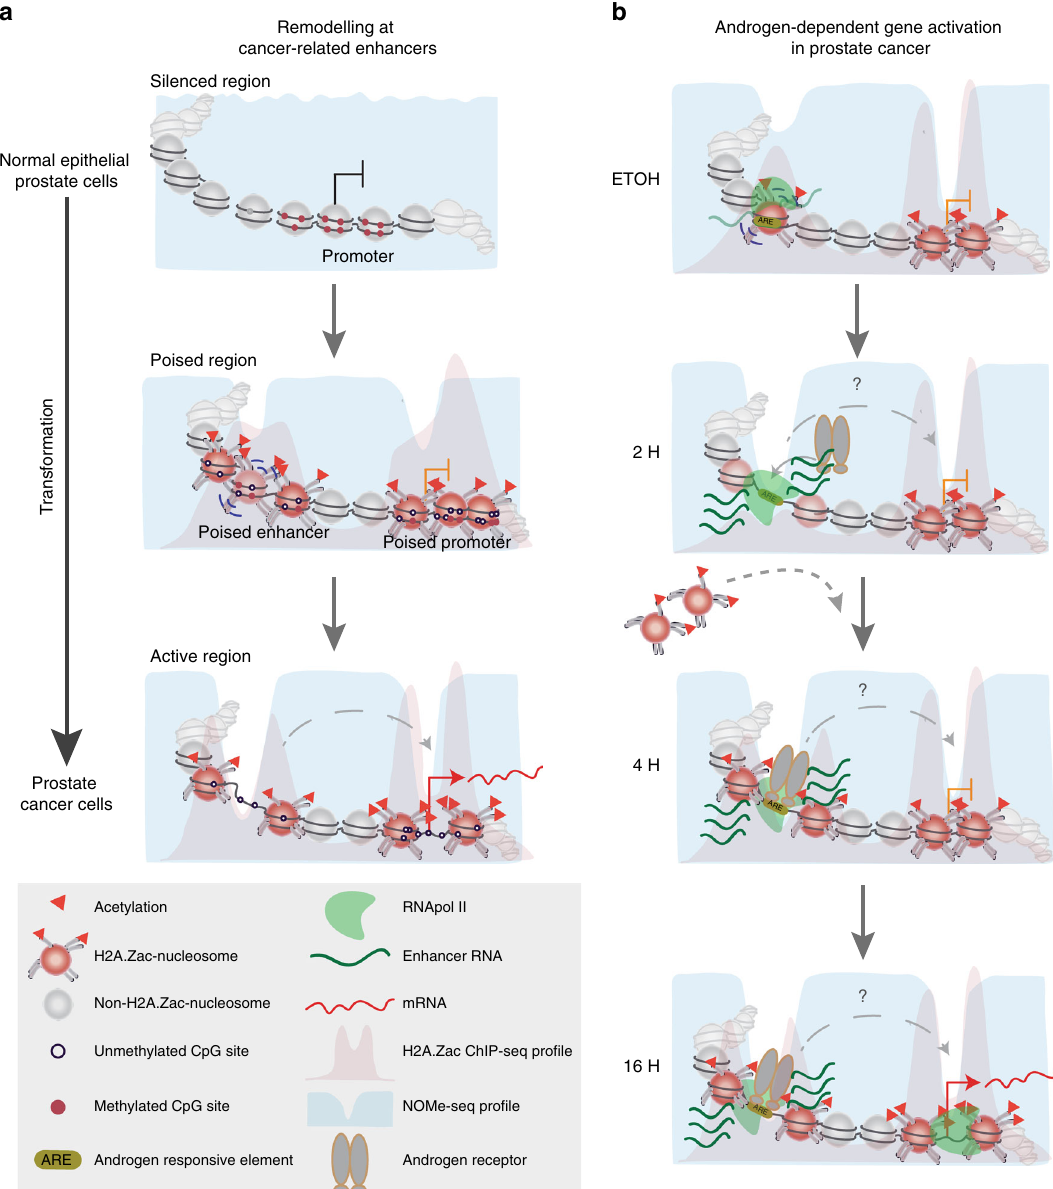
Fig. 9 Proposed model for H2A.Zac-enhancer regulation in cancer and androgen signaling. a Proposed model of regulation of cancer – activated genes. In a normal context, these genes are silenced and their promoters and enhancers do not have H2A.Zac-containing nucleosomes (Silenced region). During transformation, these genes gain poised epigenetic marks that include a gain of H2A.Zac, loss of DNA methylation and gain of chromatin accessibility at both promoters and enhancers (Poised region). In prostate cancer these genes become activated by an increase of H2A.Zac and a change in its localization from the TSS and +1, +2 nucleosome to fl ank the TSS at promoters. H2A.Zac is also increased at enhancers and it changes from occupying to fl ank NDRs. These changes are also associated with a decrease in DNA methylation. b Proposed model for H2A.Zac remodeling during androgen signaling. Androgen- sensitive genes remain in a poised state during androgen deprivation (EtOH). This state is characterized by the presence of H2A.Zac nucleosomes at 60% of all the AR enhancer sites and H2A.Zac presence at the nucleosomes fl anking the TSSs of all the androgen-sensitive genes. This subset of AR enhancer sites is also characterized by being more accessible. Upon AR activation through DHT treatment (2H, 4H, and 16H), H2A.Zac is removed/shifted to fl ank AR sites and allow AR binding. This is a very rapid process and occurs prior to gene activation and it is associated with a gain in chromatin accessibility at the AR enhancer sites. We also speculate that this remodeling facilitates the looping formation between gene promoters and AR-enhancers for